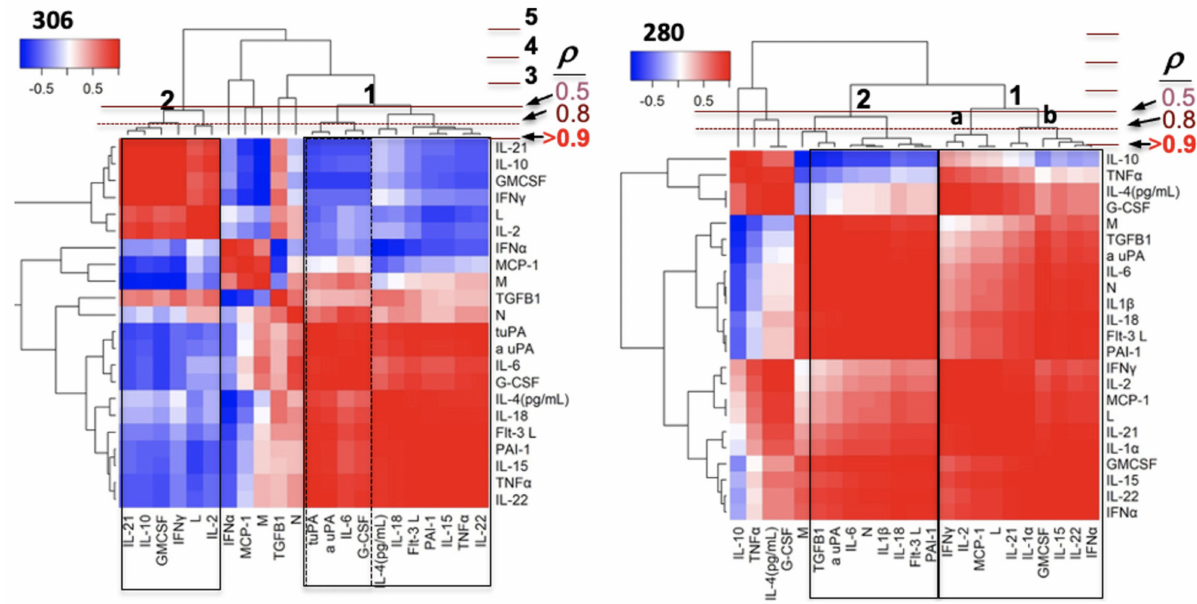
Figure 8. Unsupervised comparisons of cytokines measured at days 1–3 timepoints in each patient. Heatmap and cluster analysis of inflammatory mediators (cytokines, chemokines, growth factors, leukocytes, coagulation factors) measured in clinical patient plasma samples. A horizontal line was drawn in each heat map to indicate a suggested separation of inflammatory response patterns based on the cluster dendrograms and visual inspection of the heatmaps. The heat maps show pairwise Pearson’s correlations (color-coded: red, positive; blue, negative correlation) among inflammatory mediators sorted along both axes to emphasize object clusters using hierarchical